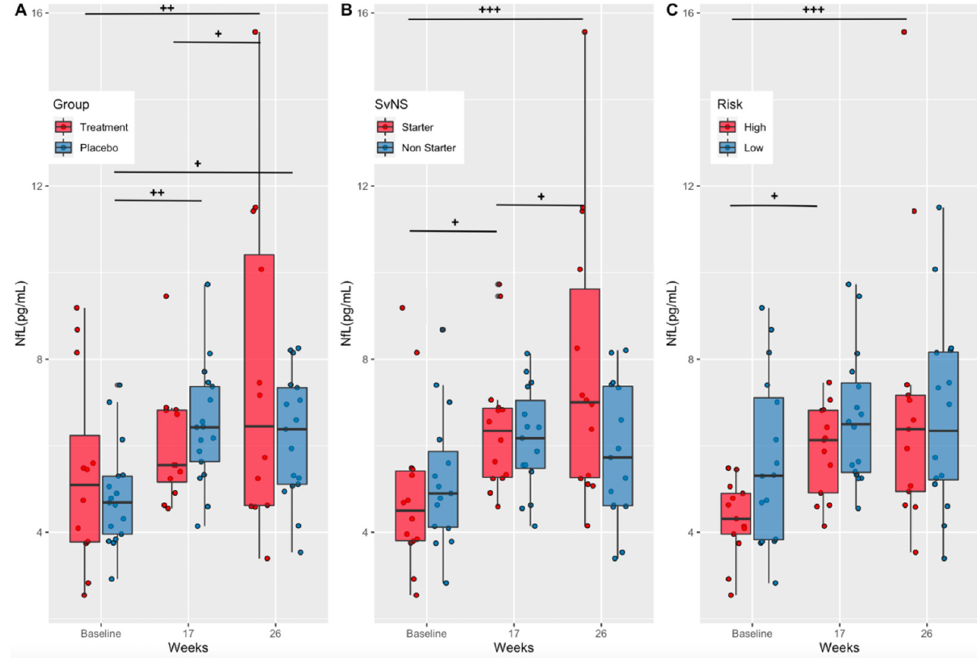
Figure 4. Serum NfL concentrations by treatment group, starter status, and risk. ( A ) Serum NfL concentrations (pg/mL) in the treatment and placebo groups at baseline, mid-season (week 17), and at end of treatment (week 26). ( B ) Serum NfL concentrations (pg/mL) in starters and non-starters at baseline, mid-season (week 17), and at end of treatment (week 26). ( C ) Serum NfL concentrations (pg/mL) in high- and low-risk position groups at baseline, mid-season (week 17), and at end of treatment (week 26). NfL, neurofilament light; p -values show significance within groups from baseline values (+) according to repeated measures ANOVA and estimated marginal means; p -values + p < 0.05; ++ p < 0.01, +++ p < 0.001, and ++++ p < 0.001.